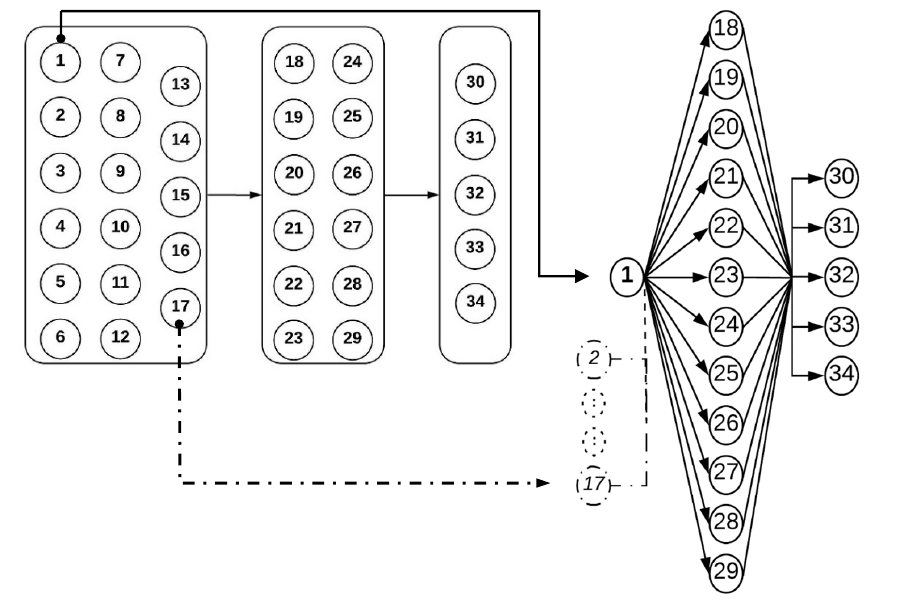
Fig.2a Precedence relations of the assembly line Fig.2b Precedence diagram of task